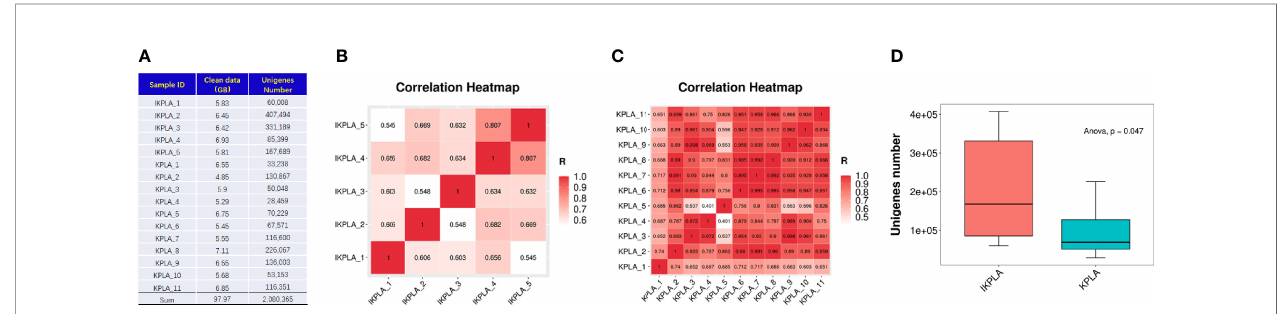
FIGURE 1 | Comparison of unigenes identi fi ed between the two groups. (A) The sequencing analysis found a total of 97.97-giga base (Gb) reads of high-quality sequences from the microbial DNA of pus samples. Using the CD-HIT program, 2,080,365 unigenes were assembled as the basis of taxonomy and functional annotation. (B, C) Analysis of the genome across different samples showed a high correlation of gene pro fi les in both groups. The color from red to white represents the correlation coef fi cient from high to low (from 1 to 0). (D) The sum of the unigene numbers of IKPLA was greater than that of KPLA (p = 0.047).